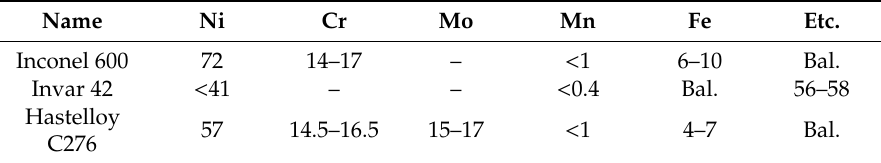
Table 1. Chemical composition of Ni-based superalloys